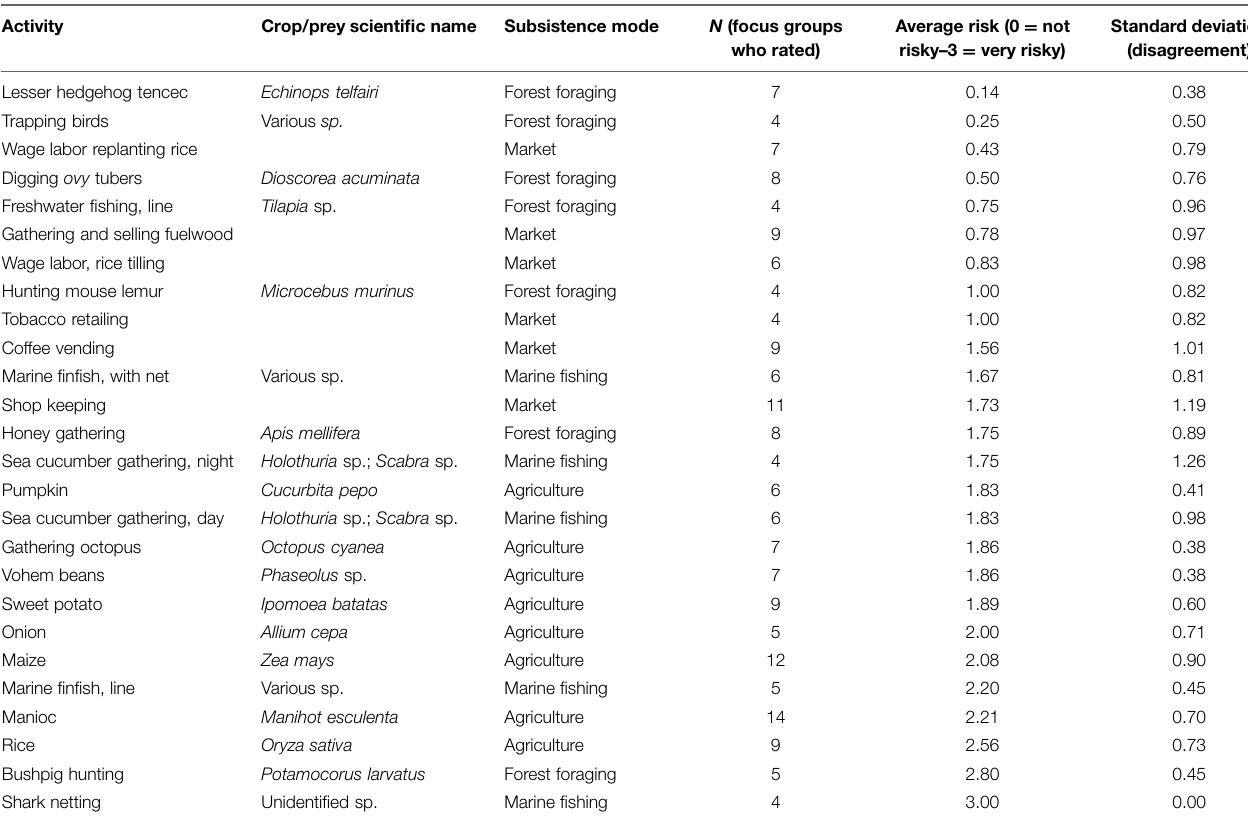
TABLE 1 | A rank ordered summary of groups’ average risk ratings for activities listed by four or more